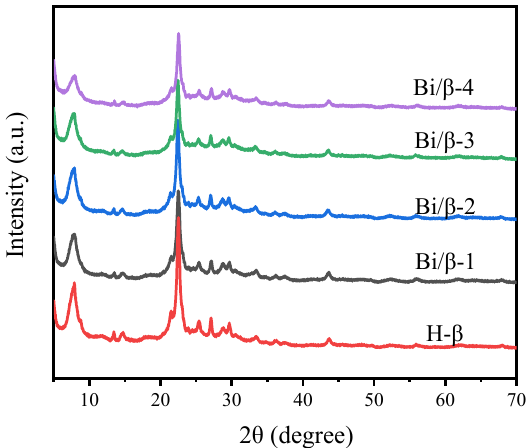
Figure 1. XRD patterns of H- β and Bi/ β zeolite catalysts with different Bi loading.